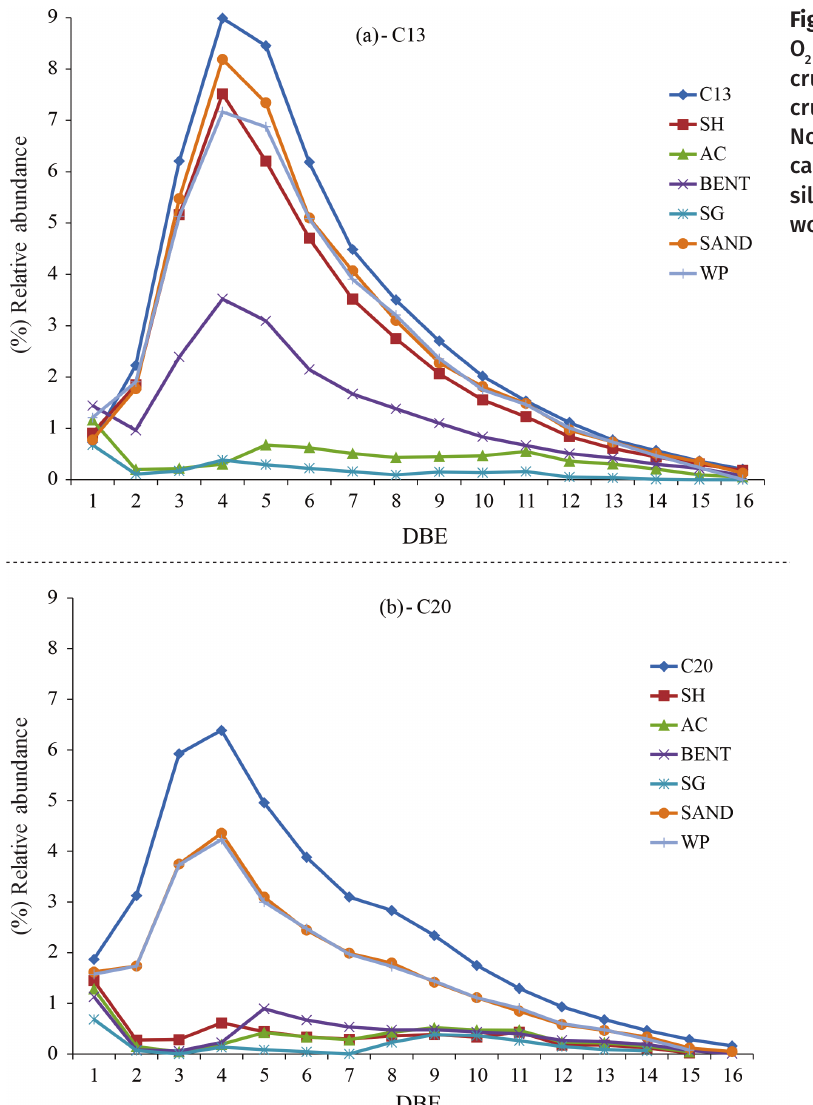
Figure 4. DBE distribution of the O class compounds for the (a) 2 crude oil C13 and filtered oils; (b) crude oil C20 and filtered oils. Note: SH= shale, AC= activated carbon; BENT= bentonite, SG= silica gel; SAND= sandstone; WP= wood